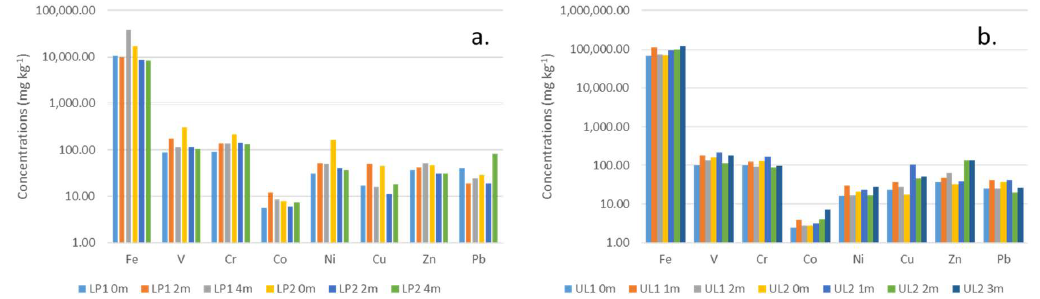
Figure 3. Trace element variations in Cretaceous ( a ) and Paleogene/Neogene ( b ) geophagic kaolinitic clays from Eastern Dahomey and Niger Delta Basins, Nigeria.